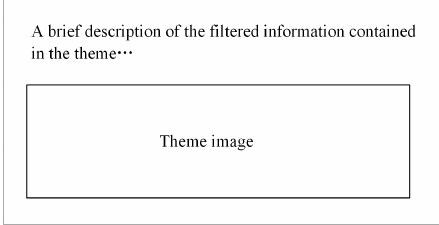
Figure 4. Microblog design diagram.